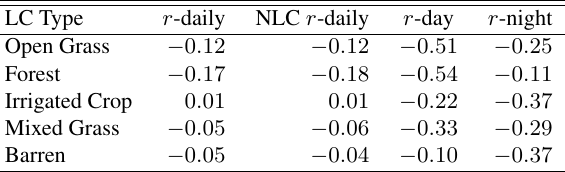
Table 2: Pearson’s r values from correlation of LST vs. in-situ SM after rainfall event on 21 st Nov. to 1 st Dec. 2011 over vari-